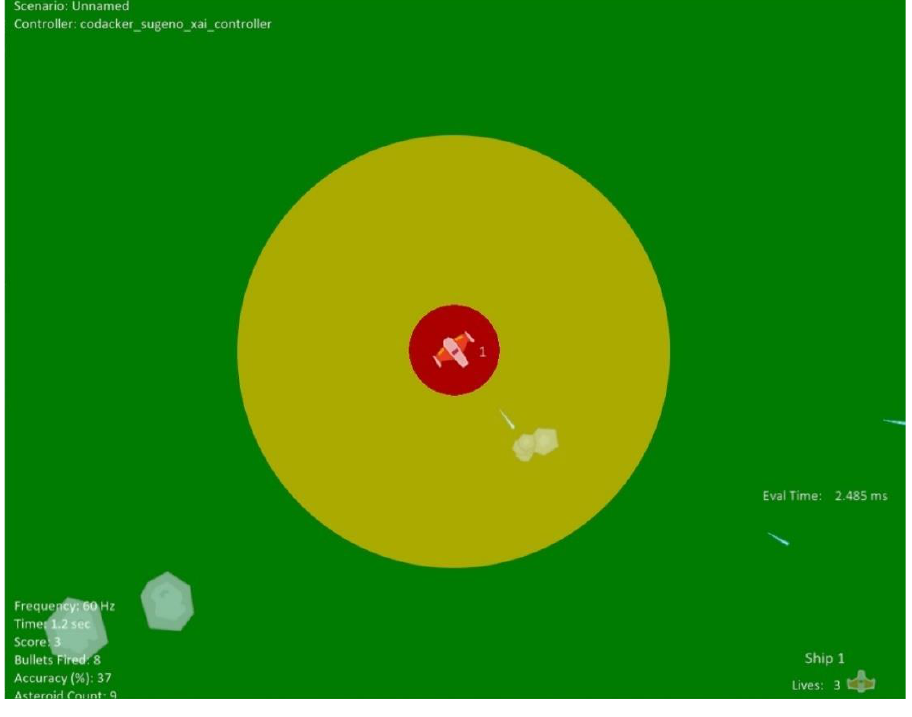
Figure 3. Agent zones and environment. Algorithm 1: Decide Agent’s